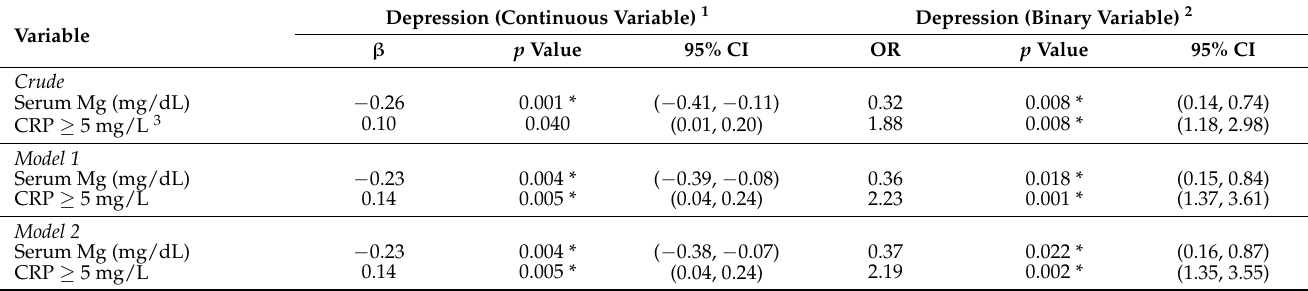
Table 2. Odds ratios and estimates of depression scores according to serum Mg and CRP levels,